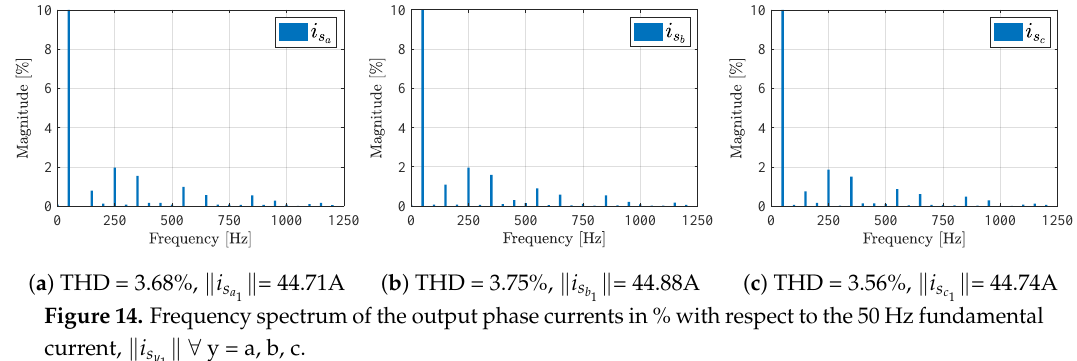
Figure 14. Frequency spectrum of the output phase currents in % with respect to the 50 Hz fundamental i s current, y = a, b, y 1 (cid:107) ∀ (cid:107)